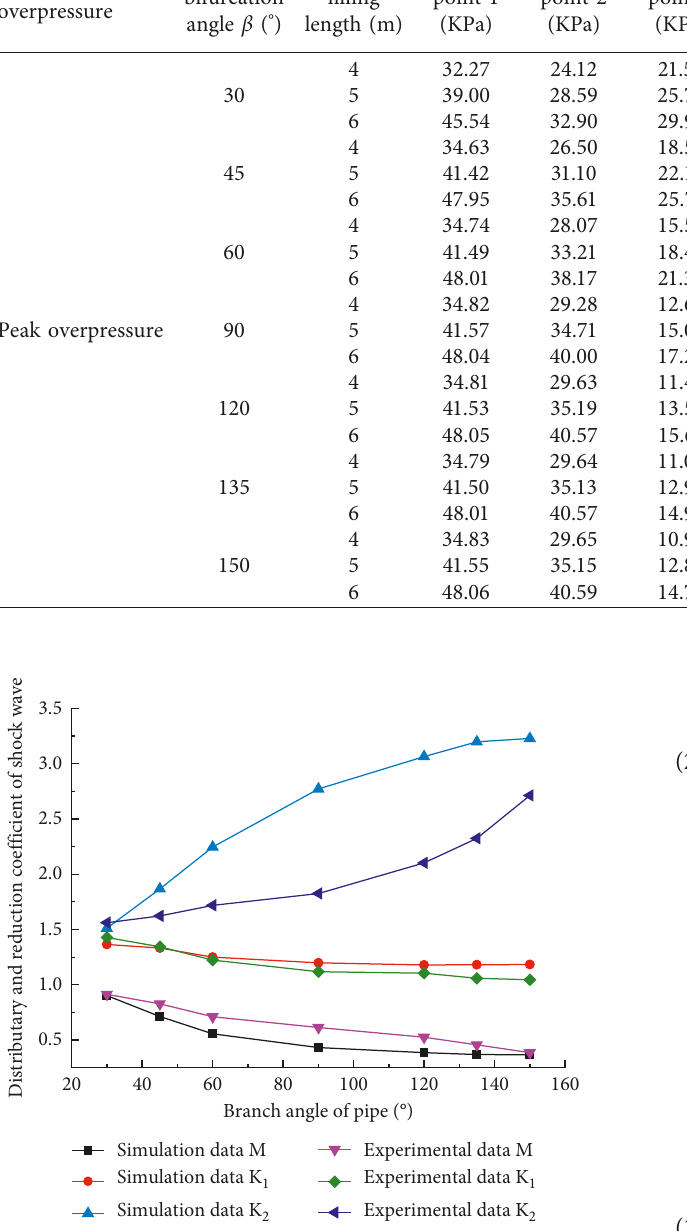
Table 3: Pressure data of the shock wave via the one-way bifurcation pipeline. Shock wave overpressure